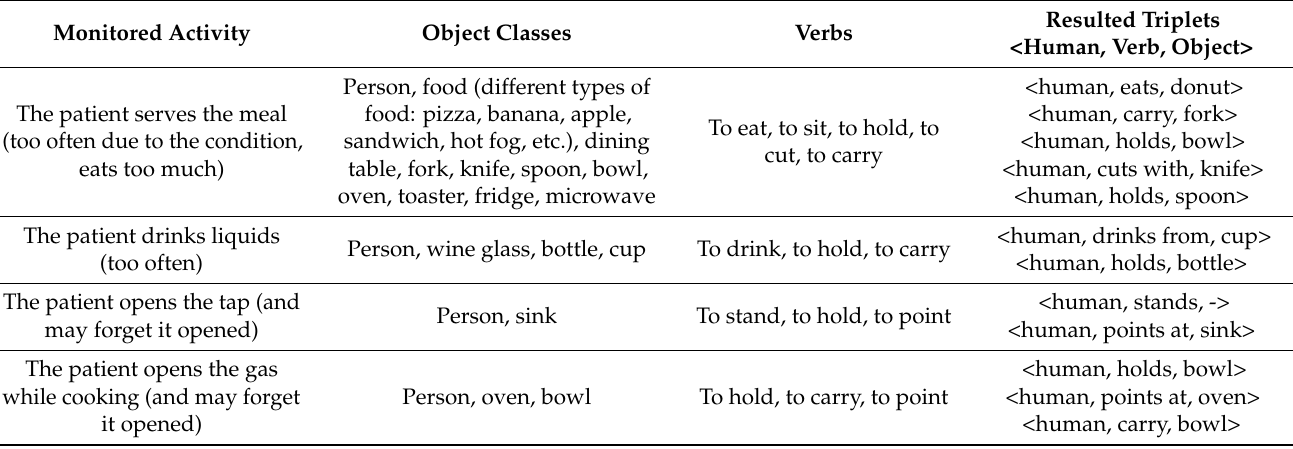
Table 2. Monitoring scenarios for Alzheimer’s disease.